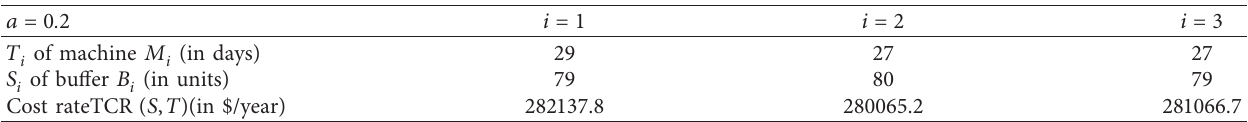
Table 4: Failure rate of virtual machine M